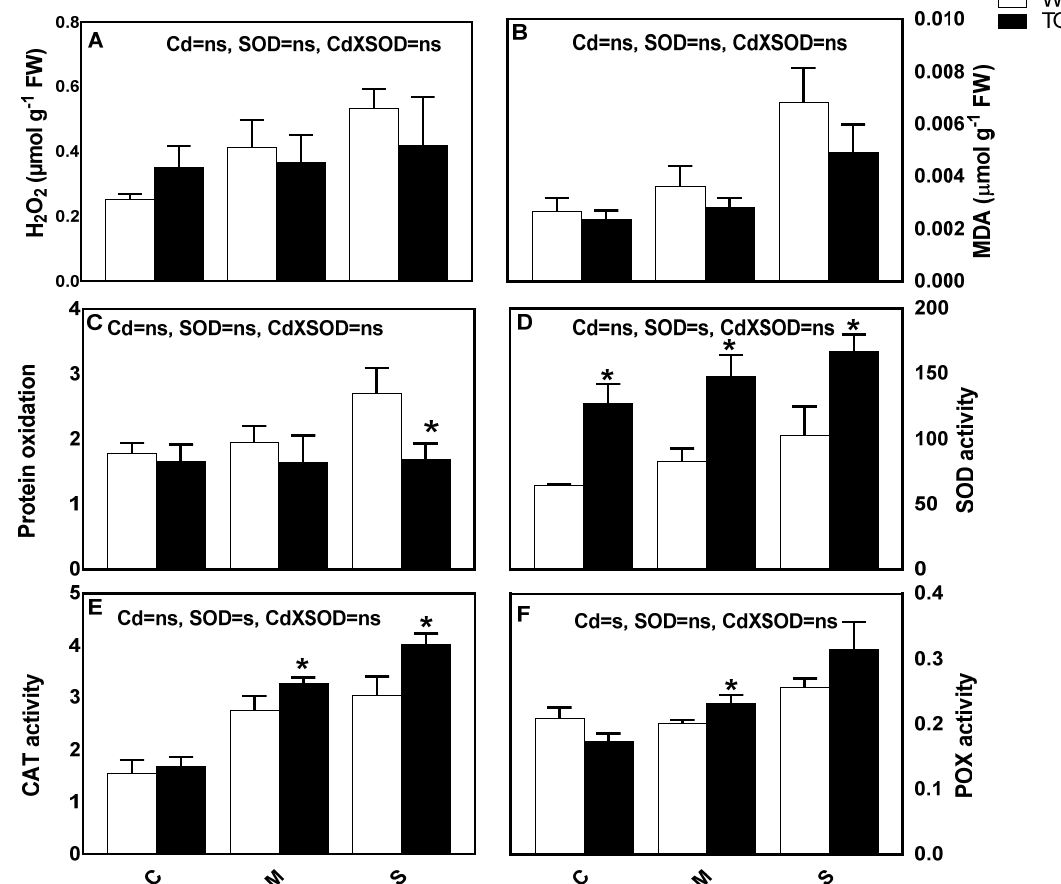
Figure 7. Effect of Cd-stress (C: control, M: mild and S: severe) on ( A ) hydrogen peroxide (H 2 O 2 ), ( B ) malondialdehyde (MDA) content, ( C ) protein oxidation, ( D ) superoxide dismutase (SOD;U SOD mg − 1 protein min − 1 ) activity, ( E ) catalase (CAT; µ mol H 2 O 2 mg − 1 protein min − 1 ) activity and ( F ) peroxidase (POX; mmol pyrogallol mg − 1 protein min − 1 ) activity of the FeSOD overexpressing maize transgenic line (TG) and its wild type (WT). Values expressed as means ± SE ( n = 5). Bars with (*) indicate significant difference. Two-way ANOVA was applied to study the effect of the two factors, Cd-stress (Cd) and SOD overexpression (SOD), as well as their interaction (Cd × SOD). Table 2. Response of photosynthesis of the FeSOD overexpressing maize transgenic line (TG) and its wild type (WT) to cadmium stress. Parameter